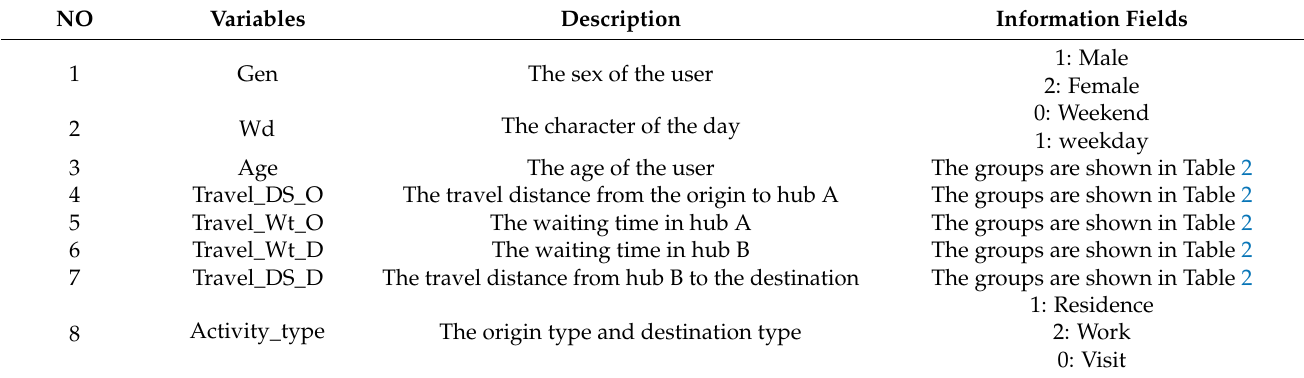
Table 9. The independent variables of the